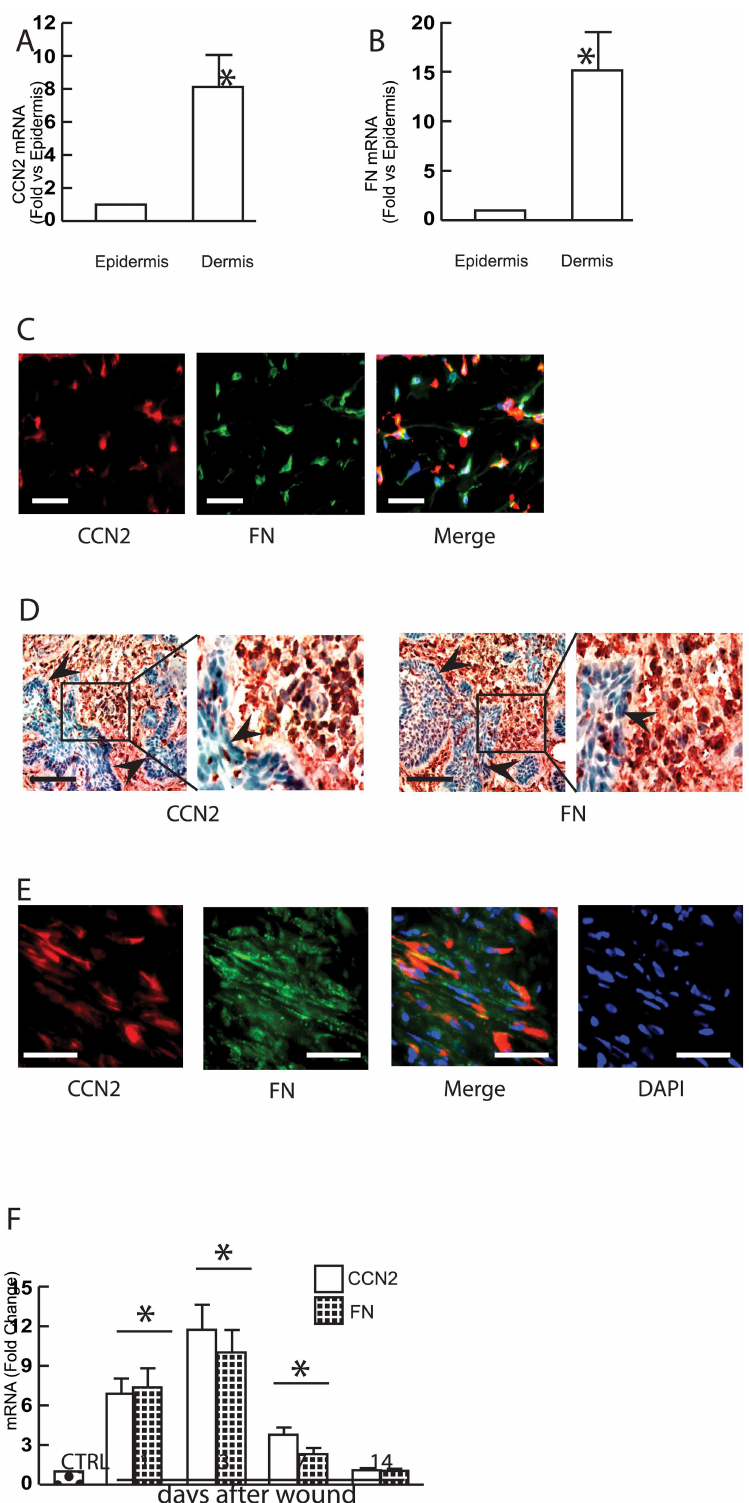
Fig 5. CCN2 and FN are primarily expressedin the dermis of normal human skin, stromal tissues of skin SCC, and wounded human skin. (A, B) Epidermisand dermis were capturedby LCM. Total RNA was extracted from captured tissue, and mRNA levels were quantifiedby real-time RT-PCR. CCN2 (A) and FN (B) mRNA levels were normalized to the housekeeping gene 36B4, as an internalcontrol for quantification. Data